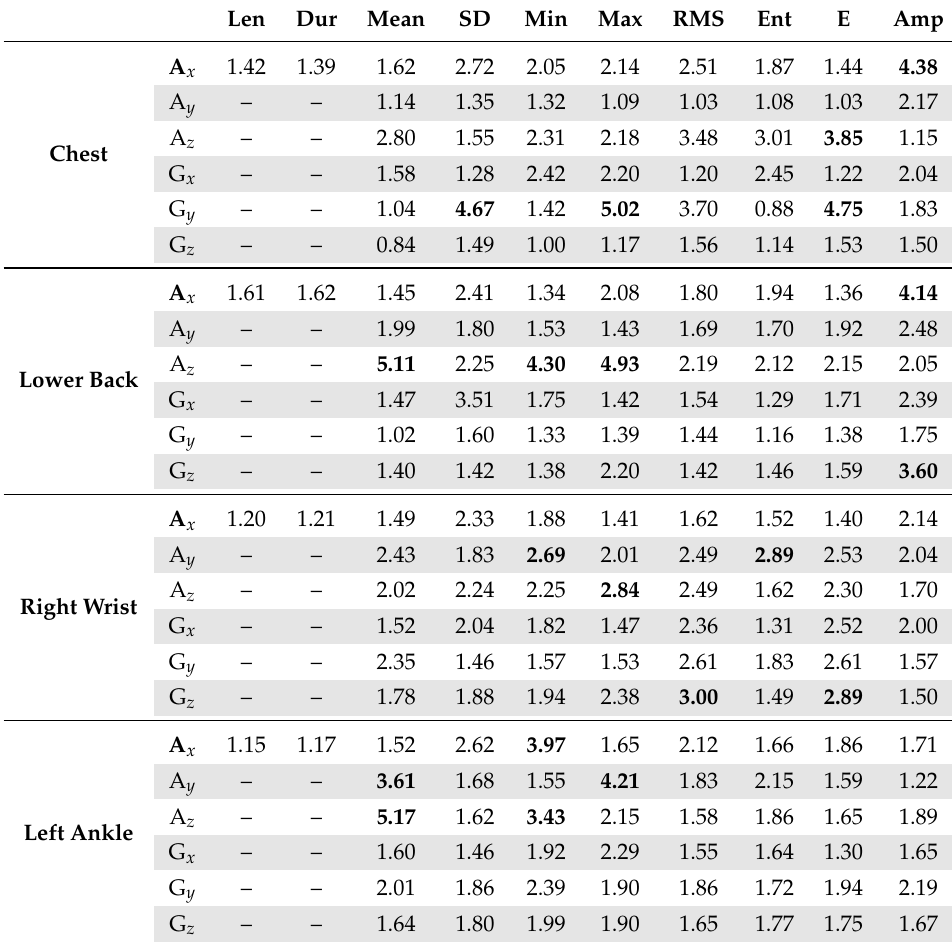
Table 7. Features importance computed during gender classification using 10-fold cross-validation strategy. The top 5 contributing features are highlighted with bold text. All values are the percentage. Len Dur Mean SD Min Max